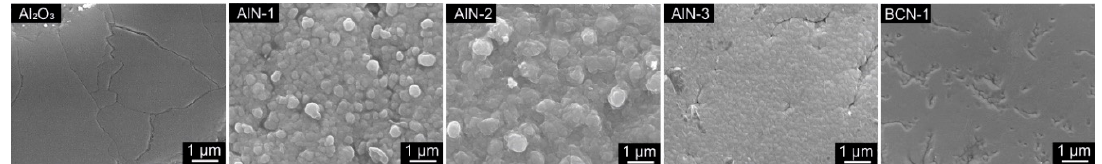
Figure 3. Scanning electron microscope (SEM) images of the topography of the polished Al 2 O 3 substrate as well as the AlN and BCN thin films. as well as the AlN and BCN thin